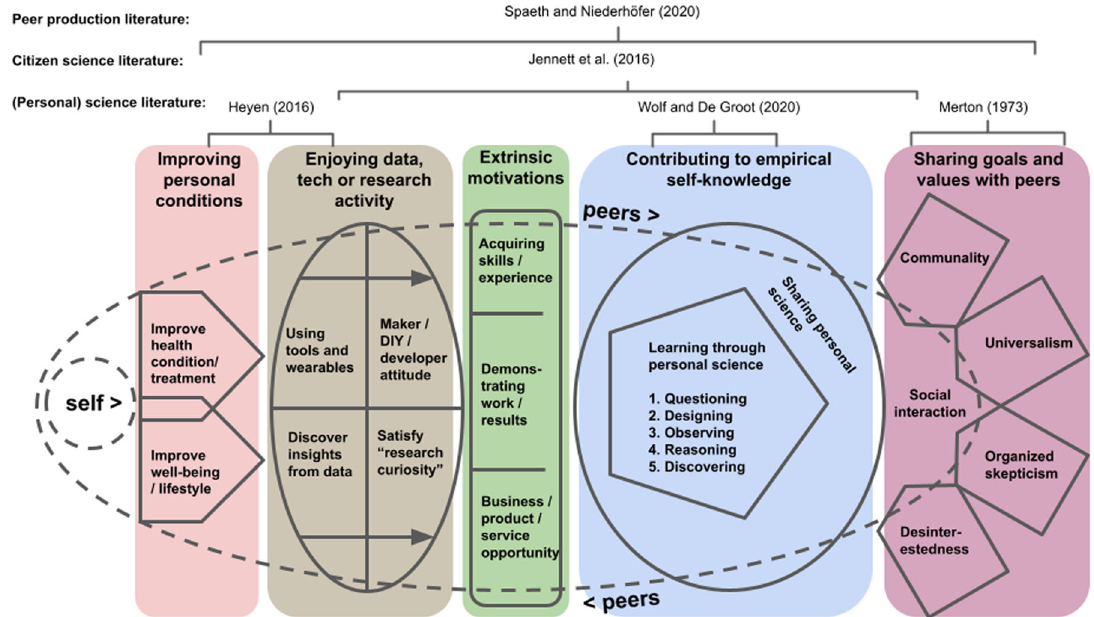
Fig. 1 Conceptual framework for the study of motivations, goals and values in personal science. It includes fi ve non-exclusive categories for analysis and its connection to previous literature in different fi